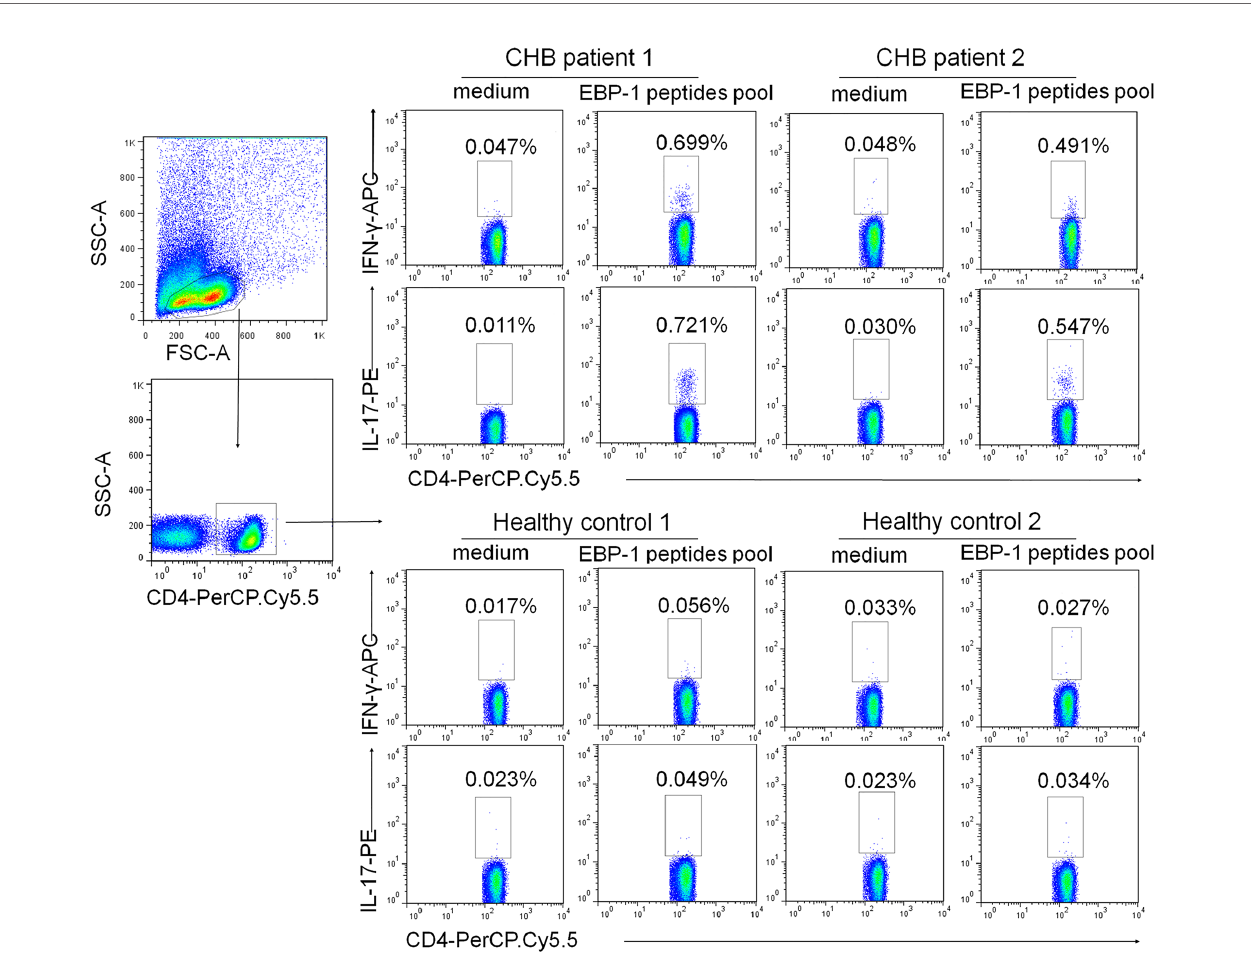
FIGURE 5 | EBP-1 peptides induced IFN- g and IL-17 expression in CD4 + T cells from CHB patients. PBMCs from 2 CHB patients and 2 HCs were stimulated with or without a synthetic EBP-1 peptides pool (18-mers overlapping by 11 amino acids, approximately 2 m g/mL for each peptide) in the presence of anti-CD28 and anti-CD49d antibodies. Representative fl ow cytometric dot plots show that the gated CD4 + cells in CHB patients express signi fi cantly increased IFN- g and IL-17 upon EBP-1 peptides stimulation compared with those in HCs. The number in each quadrant indicates the percentage of CD4 + cells expressing IFN- g or IL-17. SSC-A, side scatter area; FSC-A, forward scatter